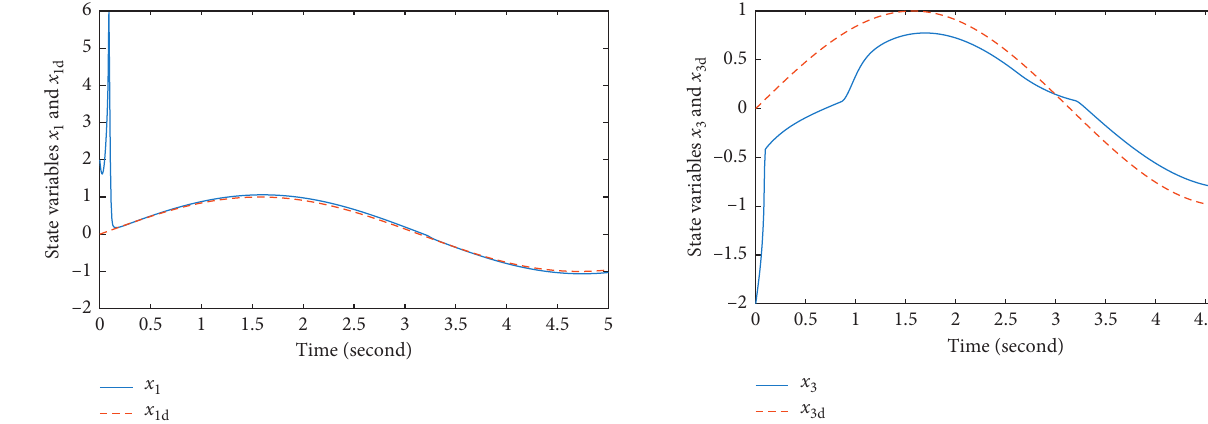
and x with control scheme (33). 3 3 d